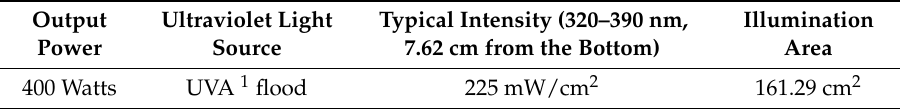
Figure 3. Schematic diagram of the curing processes of the ultraviolet ‐ curable resin bond abrasive tool through ( a ) spin ‐ coating method; and ( b ) fan ‐ shaped pieces assembly method. In the manufacturing industry of diamond abrasive tools, the diamond concentration is particularly used as a standard to evaluate the weight of diamond in a unit volume of the tool matrix, and it is defined that where each cubic centimeter contains 0.88 g of diamond, the concentration is